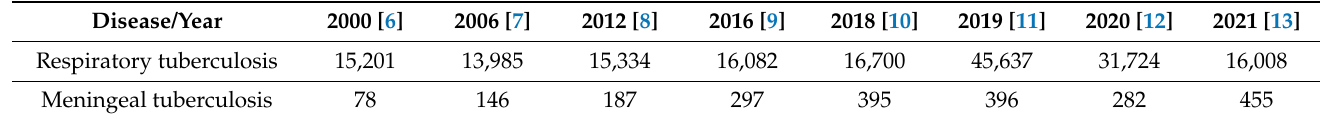
Table 1. Newly diagnosed cases of tuberculosis in Mexico: 2000–2021